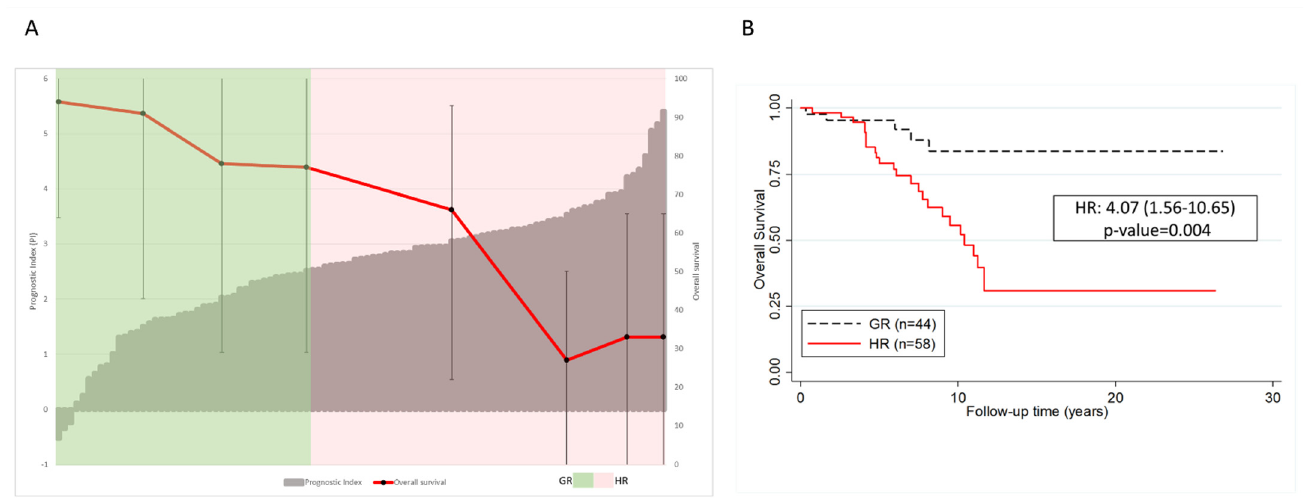
Figure 6. Prognostic index and overall survival (OS) rates (at 10-year intervals) of patients based on the integrative risk score values. The independent prognostic variables associated with OS were confirmed by multivariate analysis using the Cox proportional hazards model. ( A ) prognostic index model was established based on independent variables that were significantly associated with OS in the multivariate analysis (Table S3C). The PI of 2.60 was established as the optimal cut-point for this analysis. ( B ) Overall, the hazard ratio of comparing cases with PI ≥ 2.60 to cases with PI < 2.60